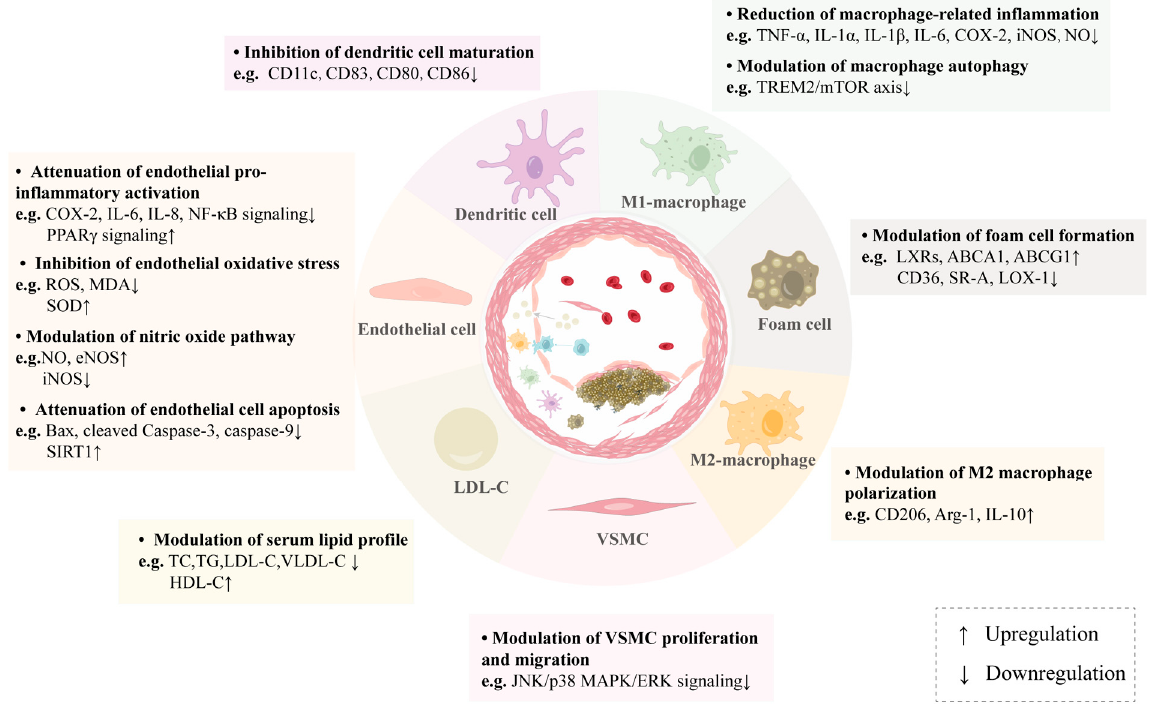
Figure 2. Pharmacological actions of natural monoterpenes on atherosclerosis. Atheroprotective monoterpenes can target vascular cells involved in atherosclerosis, including endothelial cells, monocytes/macrophages, VSMCs, and dendritic cells. Moreover, they modulate various atherogenesis-related pathological processes, such as hyperlipidemia, inflammation, oxidative stress, apoptosis, NO bioavailability, foam cell formation, autophagy, and abnormal cell proliferation and migration. This figure schematizes atherosclerotic plaque formation in the middle panel, with various target cell types (or pro-atherogenic factor) and relevant pharmacological actions of antiatherogenic monoterpenes shown around the outer margins.